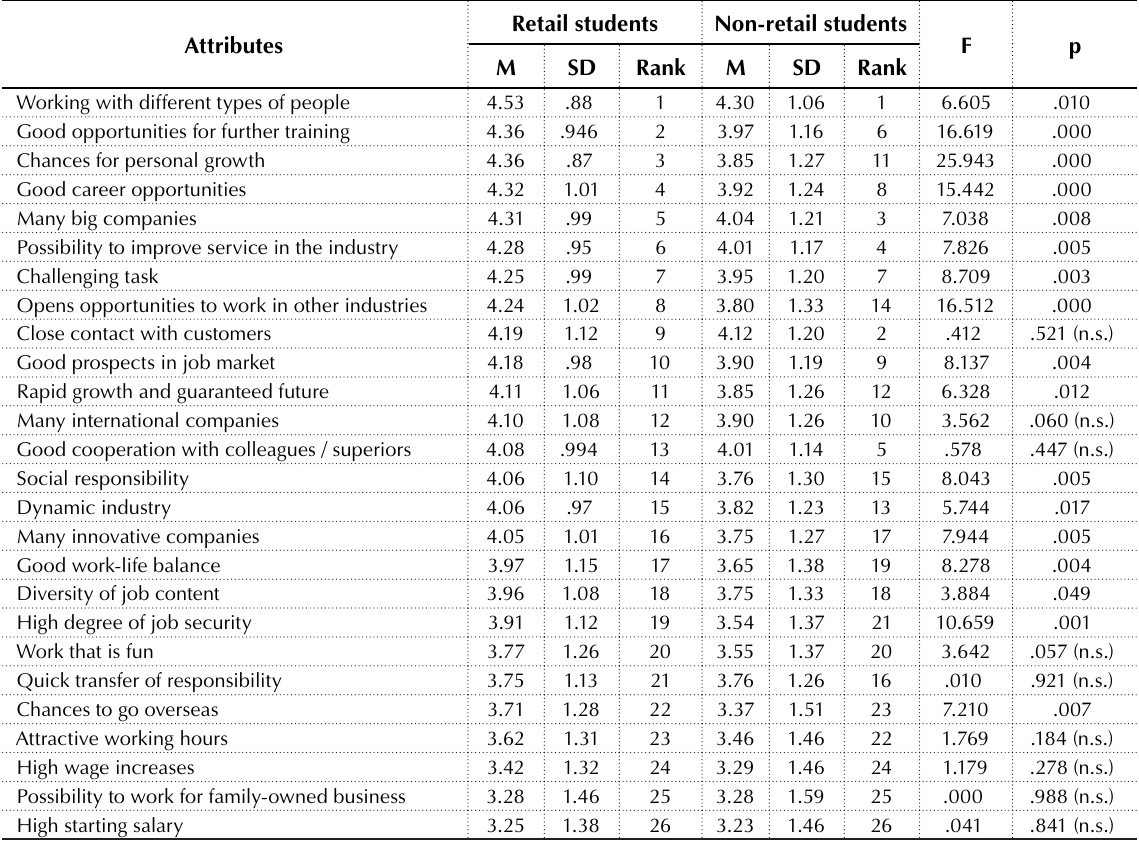
Table 9. Retail and non-retail students’ ratings of retail career